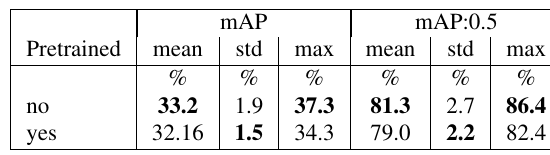
Table 8. Metrics variance over a course of experiments for a DoTA pretrained custom SSD model versus a randomly initialized